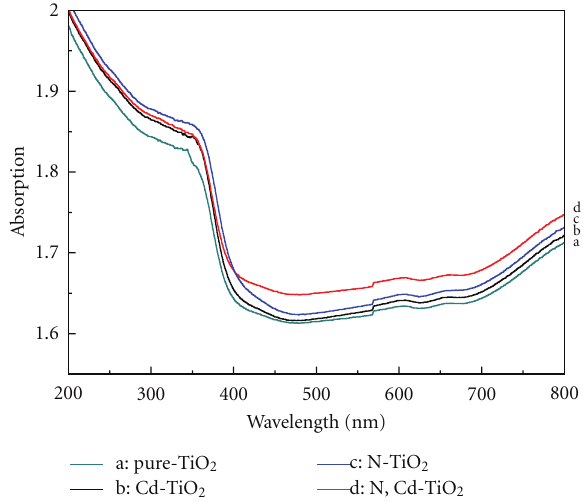
Figure 3: DRS of photocatalysts: a: pure TiO 2 , b: Cd-doped TiO 2 , c: N-doped TiO 2 , and d: N, Cd-codoped TiO 2